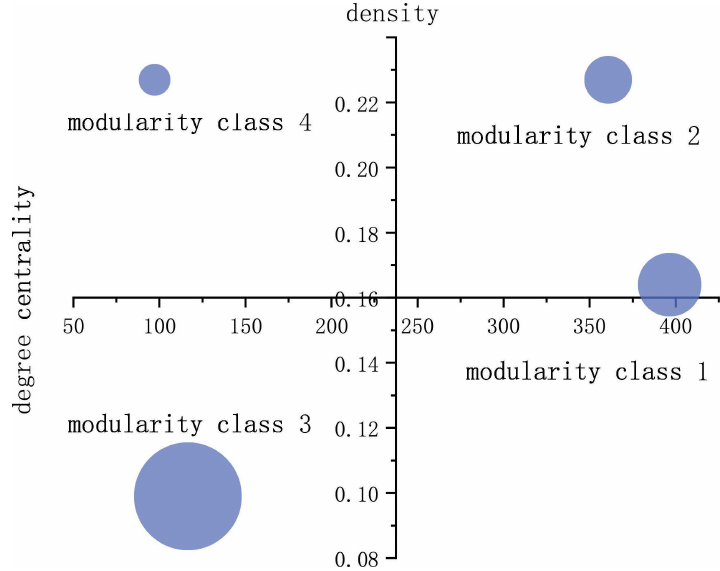
Figure 12. Attribute comparison of four modularity communities in traffic